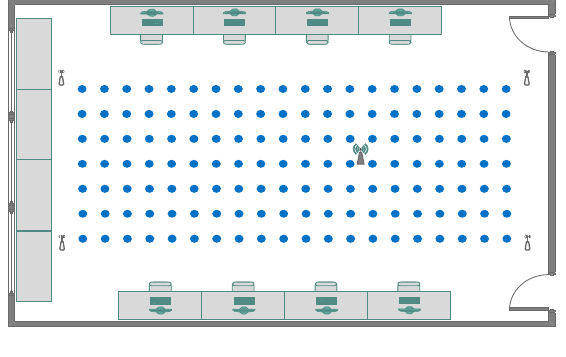
Figure 9. The Testbed.